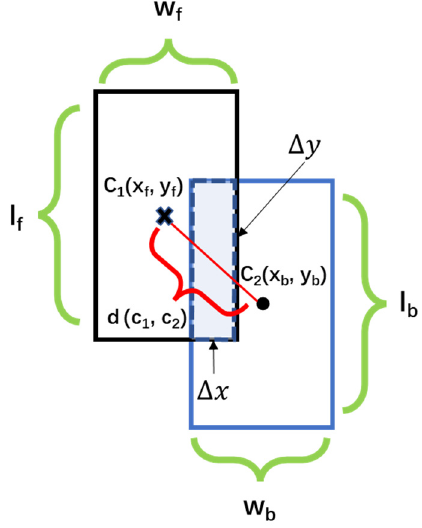
Figure 5. The reduction in length and width between the overlapping boxes. For CD IoU , in the case when B f and B b overlap exactly, CD IoU = 0. When the input target bounding boxes partially overlap, the further the distance between the center points, the